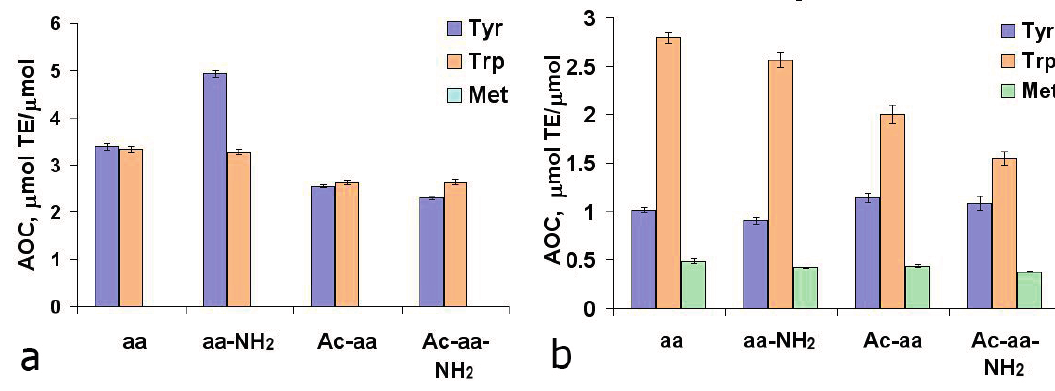
Figure 1. Antioxidant capacity of acetylated (Ac) and/or amidated (NH 2 ) amino acids in TEAC ( a ) and ORAC ( b )